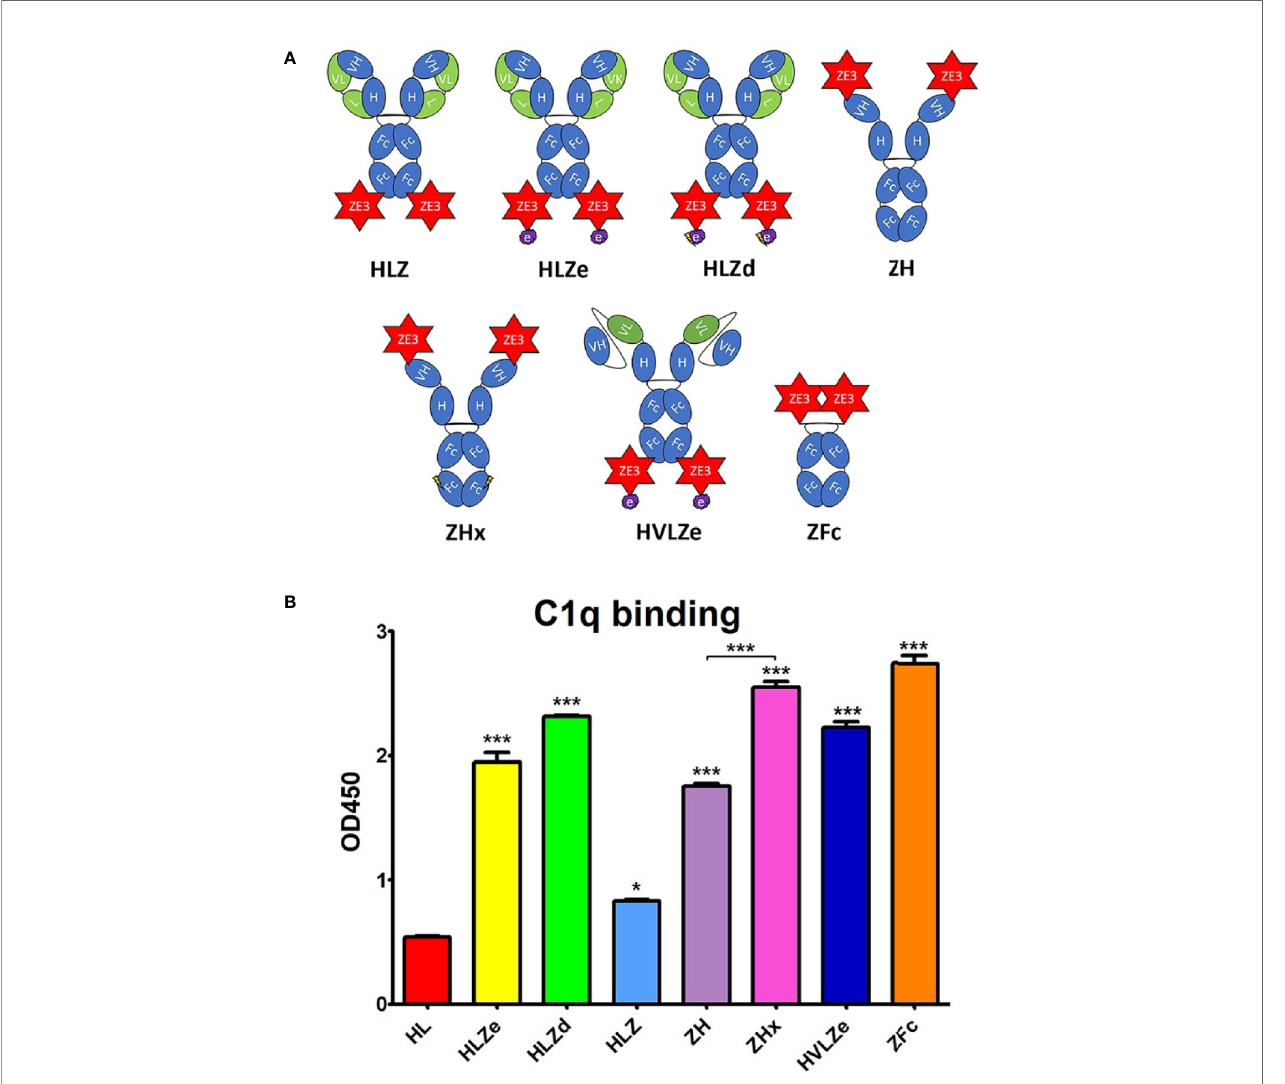
FIGURE 1 | Various IgG fusion strategies enhance C1q binding (A) . Schematic representation of IgG fusion constructs used in this study. Fusion constructs are built on the mAb 6D8 human IgG1 backbone with the shown modi fi cations. ZE3; the Zika envelope domain III containing amino acids K301 to T406; e, an epitope tag containing the “ VYKLDISEA ” 6D8 binding motif for RIC formation; e with lightning bolt, an epitope tag truncated to include only “ YKLDIS ” to reduce RIC formation; VH, the variable heavy domain from 6D8 which participates in binding the epitope tag; VL, the variably light domain from 6D8 which participates in binding the epitope tag; H, the heavy chain constant CH1 domain from 6D8; L, the light chain constant domain from 6D8; Fc, the heavy chain constant CH2 or CH3 domains from 6D8; Fc with lightning bolt, same as Fc but with E345R, E430G, and S440Y mutations to induce hexamer formation (B) . C1q binding ELISA of puri fi ed IgG fusion constructs made in plants that lack plant-speci fi c b 1,2-linked xylose and a 1,3-linked fucose N-linked glycans. ELISA plates were coated with 15 m g/ml human C1q and incubated with 10 m g/ml each molecule, using 6D8 with no fusion as a negative control. Constructs were detected using polyclonal goat anti-human IgG- HRP. Mean OD 450 values from three samples are shown ± standard error with one star (*) indicating p < 0.05 and three stars (***) indicating p < 0.001 as measured by one-way ANOVA comparing each column to the control column HL, unless otherwise indicated with a